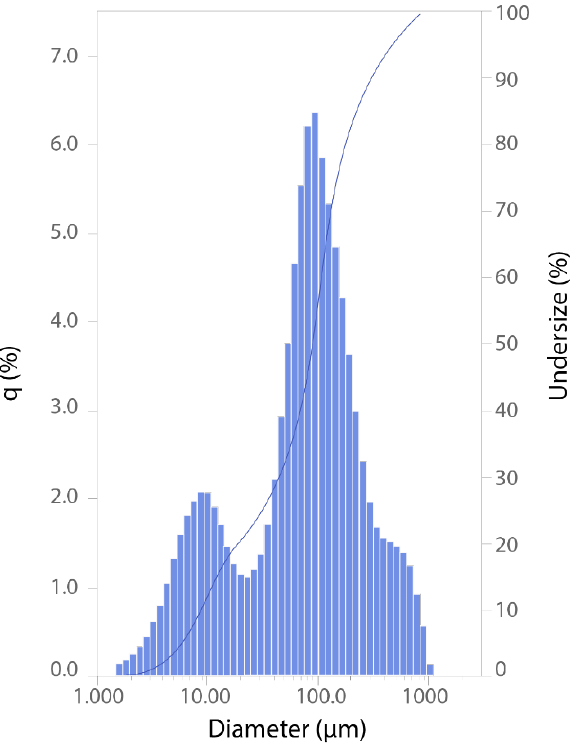
Figure 2. Particle size distribution in the processing waste of the TSF.